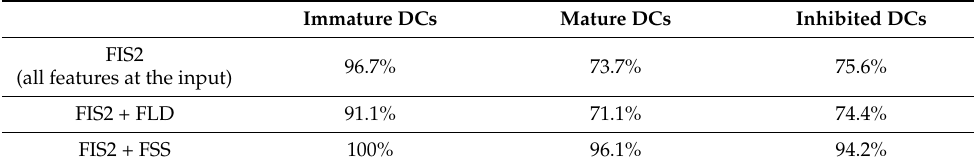
Table 6. Correct classification rate of the three classes with the FIS2